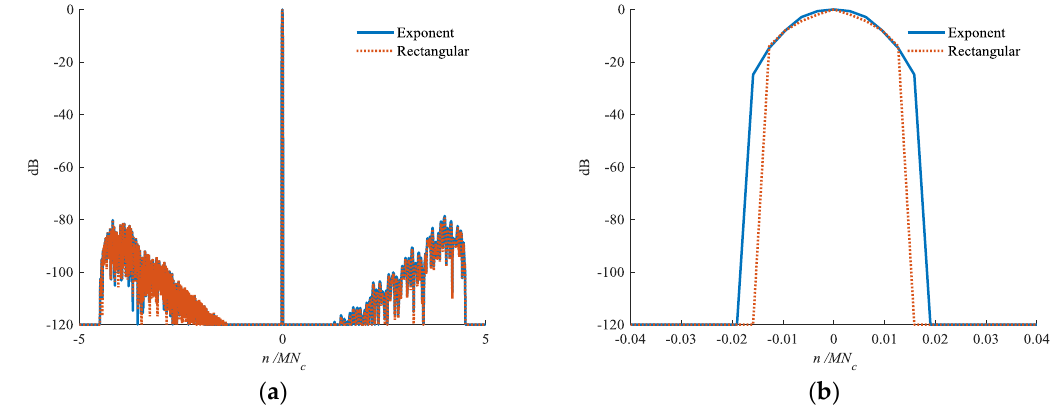
h n and   g n in: ( a ) Overall view and ( b ) Mainlobe area, respectively. Figure 4. Output of   Figure 4. Output of h k ( n ) and g k ( n ) in: ( a ) Overall view and ( b ) Mainlobe area, k k